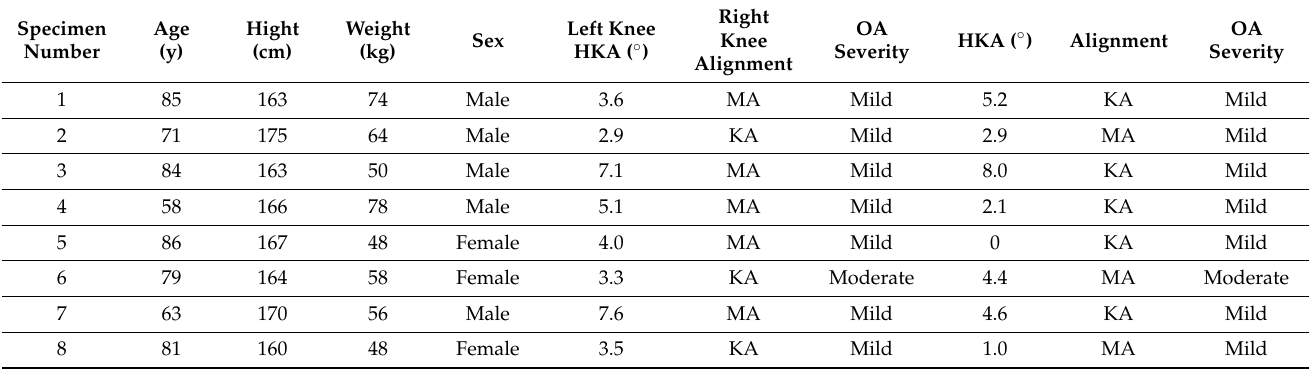
Table 1. Demographic variables of the